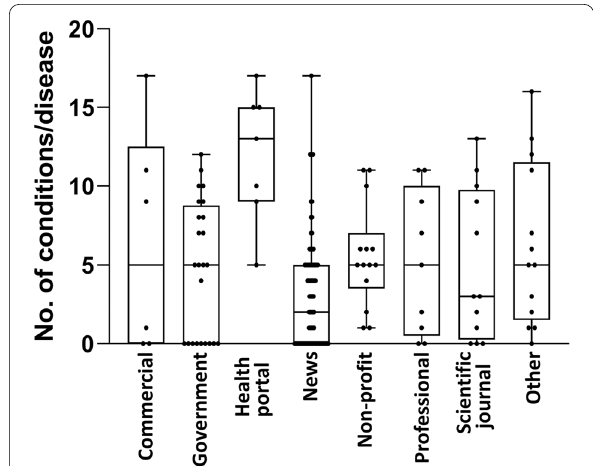
Fig. 3 Number of indications mentioned by webpages of different typologies. Data represent the number of conditions mentioned as median, IQR (interquartile range), minimum, maximum. C, commercial; G, government; HP, health portals; N, news; NP, no profit; P, professional; SJ, scientific journal; O, other (unclassified)